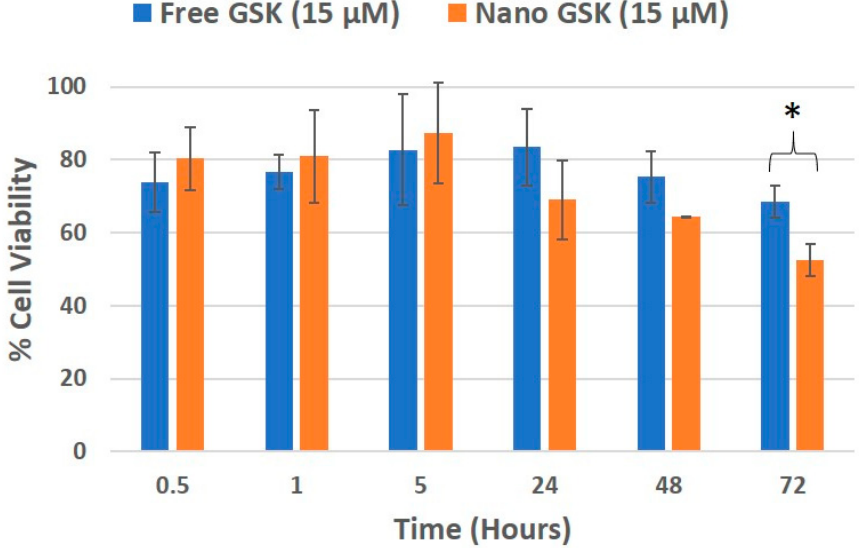
Figure 9. Cell viability trend of U87-MG treated with 15 µM GSK, that corresponds to the release profile. * ( p < 0.05). profile. * ( p <